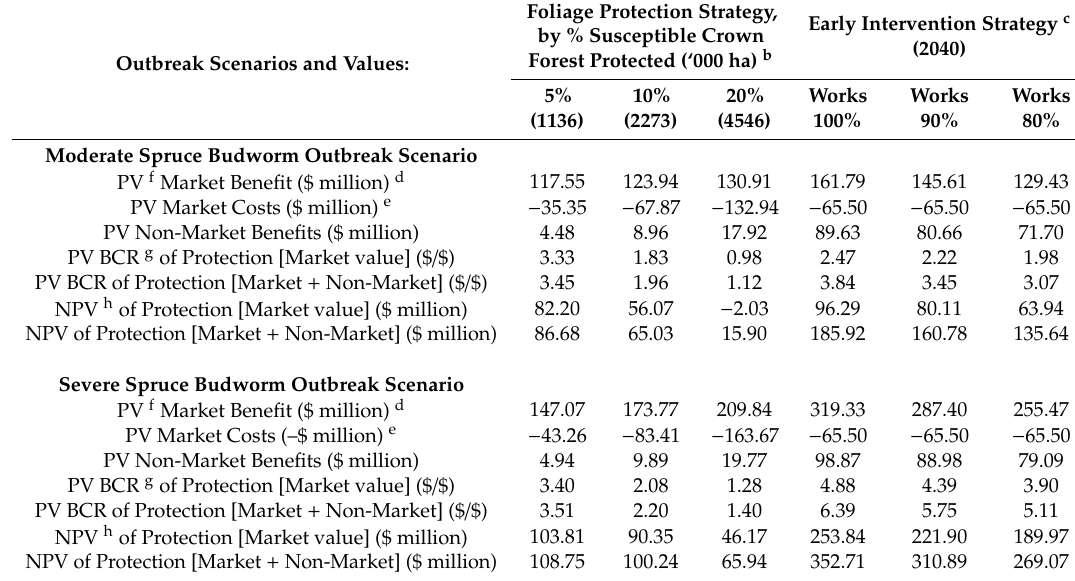
Table 4. Projected present value a benefits and costs of spruce budworm control programs on Crown land in New Brunswick over 50 years from 2010 to